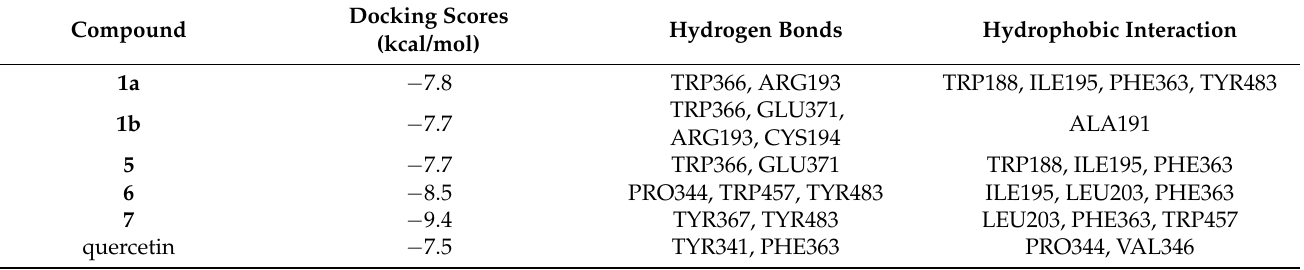
Table 3. Docking results of active compounds with the iNOS